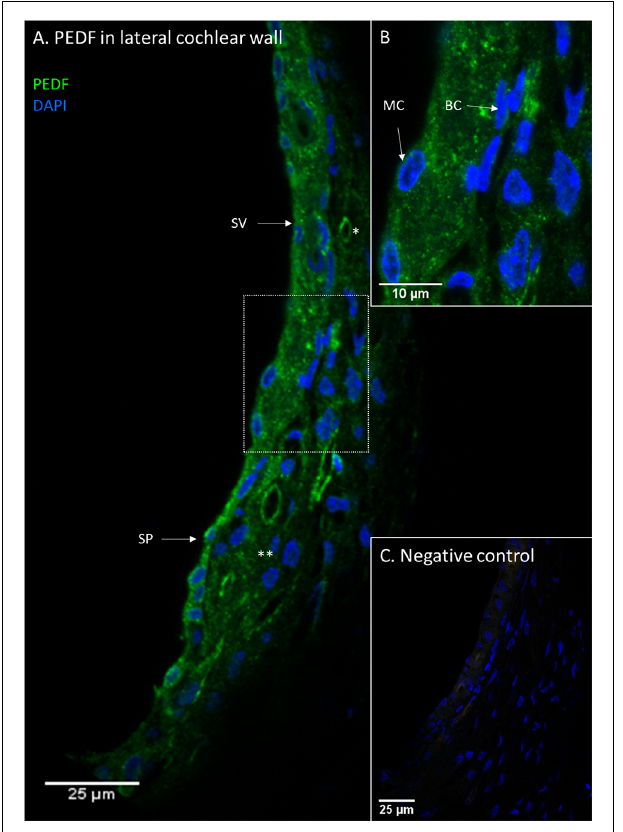
FIGURE 5 | PEDF in the lateral cochlear wall. PEDF protein localization in the lateral cochlear wall. Stria vascularis (SV); Spiral prominence (SP); Marginal cell (MC); Basal cell (BC); type I fibrocytes (*); type II fibrocytes (**). (A) PEDF was localized to the spiral ligament, the stria vascularis and the spiral prominence. In the spiral ligament were type I and II fibrocytes PEDF positive. (B) Inset of higher magnification of marked area in (A) . The distribution of PEDF in sub-cellular level of stria vascularis and spiral ligament. (C) Negative control of the immunohistochemistry.